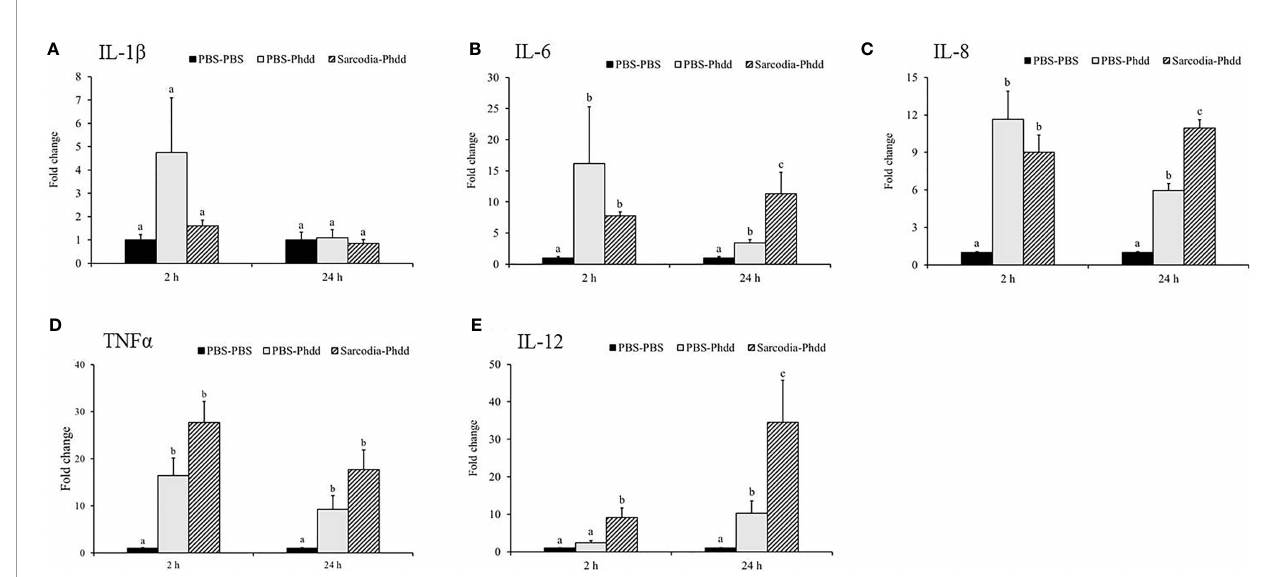
FIGURE 7 | Expression of cytokine genes in the head kidney (HK) tissue from fi sh intraperitoneal injected with PBS and Sarcodia suiae water extract after challenge with Photobacterium damselae subsp. damselae ( Phdd ). The relative expression pro fi le of (A) IL-1 b , (B) IL-6 , (C) IL-8 , (D) TNF a , and (E) IL-12 in the HK samples was analyzed. The values are shown as mean + SEM (N = 3). Signi fi cant differences ( p < 0.05 ) are indicated by different letters.